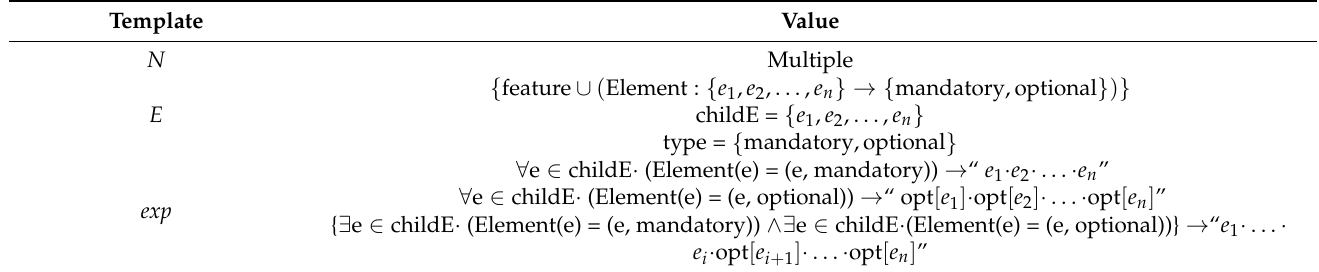
Table 1. Multiple template.